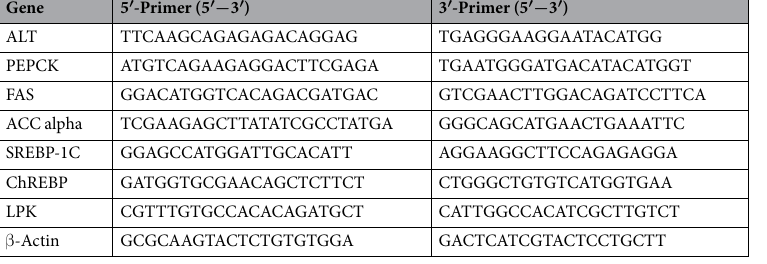
Table 1. RT-PCR primer